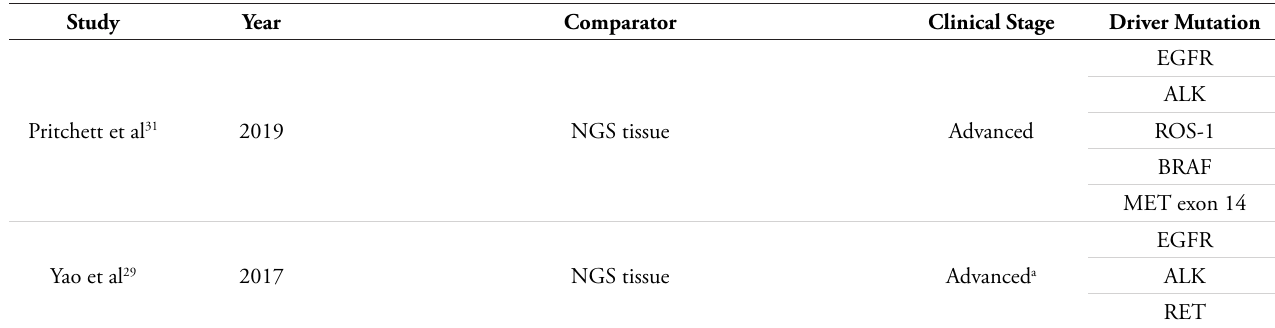
Table 1. Characteristics of Eligible Studies Study